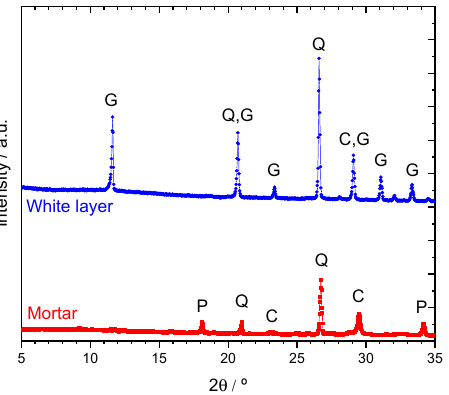
Figure 6. Diffractograms of mortar before testing (Mortar) and the white layer at the top surface of the sample (White layer). P—portlandite, Q—quartz, C—calcite, and G—gypsum.